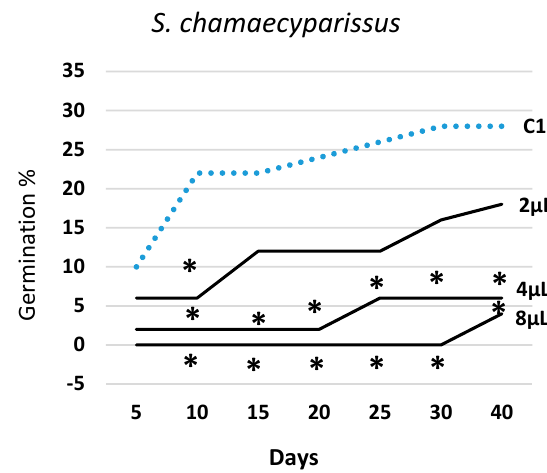
Figure 2. Trend over time of percent seed germination (cumulated values) in Erigeron bonariensis exposed to four EOs at three doses (2 µL, 4 µL, 8 µL). For each observation day, values marked with * are significantly different from the water control (C1; dotted line) at P ≤ 0.05 (Dunnett’s test).